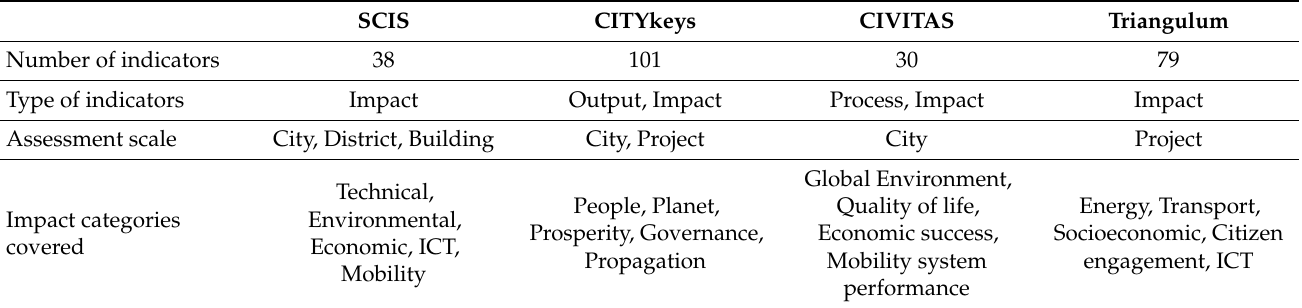
Table 1. KPIs overview from relevant